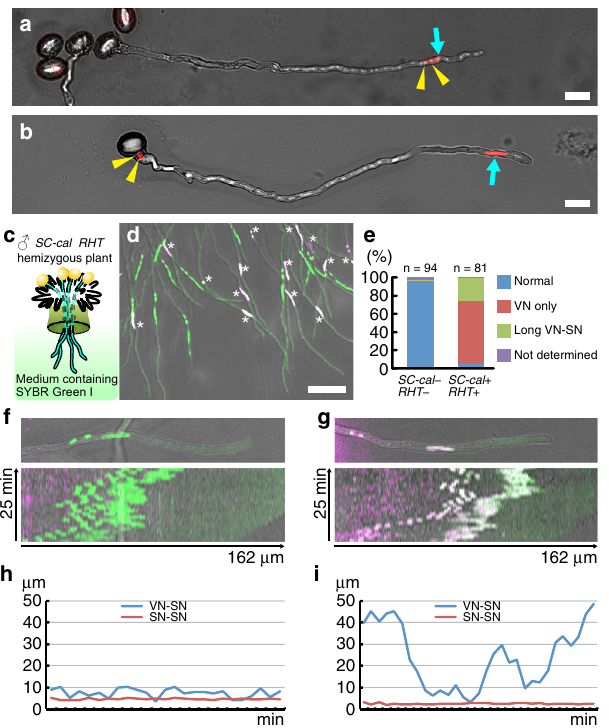
Fig. 3 Aberrant apical transport of the callose-accumulating sperm cells. a In vitro-germinated pollen tube from a plant transformed with only pRPS5A: H2B-tdTomato ( RHT ) nuclear marker. b In vitro-germinated pollen tube from a double transgenic plant harboring pHTR10:cals3m ( SC-cal ) and RHT ( SC-cal RHT hemizygous plant identical to the line used in Fig. 2). Yellow arrowheads and cyan arrows represent the sperm nuclei and vegetative nuclei, respectively. Representative images obtained using eleven ( a ) or seven ( b ) independent assays are shown. Scale bar: 20 μ m. c Schematic drawings of the semi-in vitro pollen-tube growth assay. d – i Semi-in vitro pollen-tube growth assay of the SC-cal RHT hemizygous plant on a medium containing SYBR Green I for nuclear staining. Apical region of pollen tubes containing tdTomato-negative nuclei ( SC-cal − RHT − , green nuclei) or tdTomato- positive nuclei ( SC-cal + RHT + , magenta or white nuclei indicated by asterisk) in a representative image obtained from three independent assays ( d ). Frequency of nuclear patterns ( e ). Note that vegetative nuclei with no sperm cell around (VN only) or apart from two sperm cells (Long VN – SN) were frequently observed in the SC-cal + RHT + pollen tubes. Scale bar: 50 μ m. Representative images of the SC-cal − RHT − ( f ) or SC-cal + RHT + ( g ) pollen tubes with kymographs of nuclear movement. The vertical and horizontal axes represent time and distance along the pollen tube, respectively. Transitions of distances from the vegetative nucleus to the front sperm nucleus (VN – SN) or the distance between two sperm nuclei (SN – SN) in ( f and g ) were analyzed in ( h and i ),